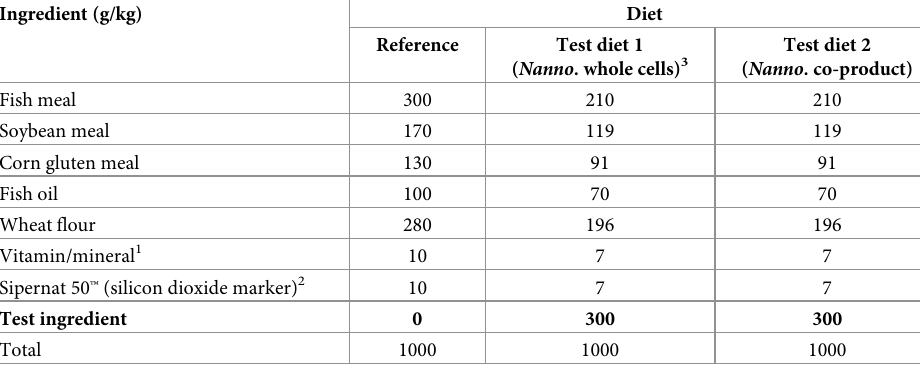
Table 1. Ingredient composition of the reference diet (g kg -1 ). Ingredient (g/kg) Diet Reference Test diet 1 Test diet 2 ( Nanno . co-product) ( Nanno . whole cells) 3 Fish meal 300 210 210 Soybean meal 170 119 119 Corn gluten meal 130 91 91 Fish oil 100 70 70 Wheat flour 280 196 196 Vitamin/mineral 1 10 7 7 Sipernat 50™ (silicon dioxide marker) 2 10 7 7 Test ingredient 0 300 300 Total 1000 1000 1000 1 Vitamin/mineral premix (mg kg - 1 dry diet unless otherwise stated):vitamin A (as acetate), 7500 IU kg - 1 dry diet; vitamin D3 (as cholecalcipherol), 6000 IU kg - 1 dry diet; vitamin E (as DL-a-tocopherylacetate), 150 IU kg - 1 dry diet; vitamin K (as menadione Na-bisulphate), 3; vitamin B12 (as cyanocobalamin), 0.06; ascorbic acid (as ascorbyl polyphosphate), 150; D-biotin, 42; choline (as chloride), 3000; folic acid, 3; niacin (as nicotinic acid), 30; pantothenic acid, 60; pyridoxine, 15; riboflavin, 18; thiamin, 3; NaCl, 6.15; ferrous sulphate, 0.13; copper sulphate, 0.06; manganese sulphate, 0.18; potassium iodide, 0.02; zinc sulphate, 0.3; carrier (wheat middling or starch). 2 Sipernat 50 ™ : Source of acid insoluble ash comprised of 98.50% SiO 2 with an average particle size of 50 μ m. 3 Nanno refers to Nannochloropsis oculata